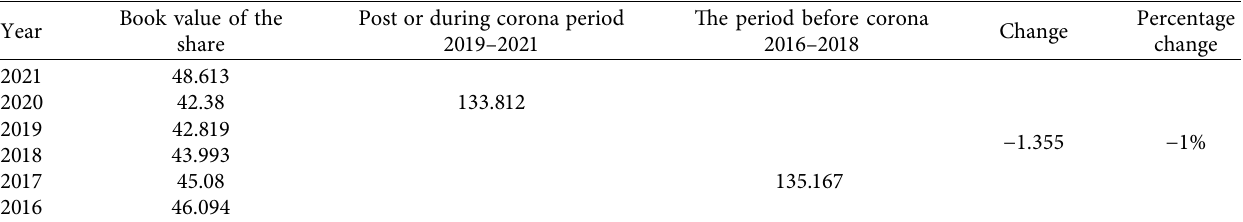
Table 4: Tthe evolution of the book value of the stock for the study sample companies before and after the efects of the Corona pandemic.